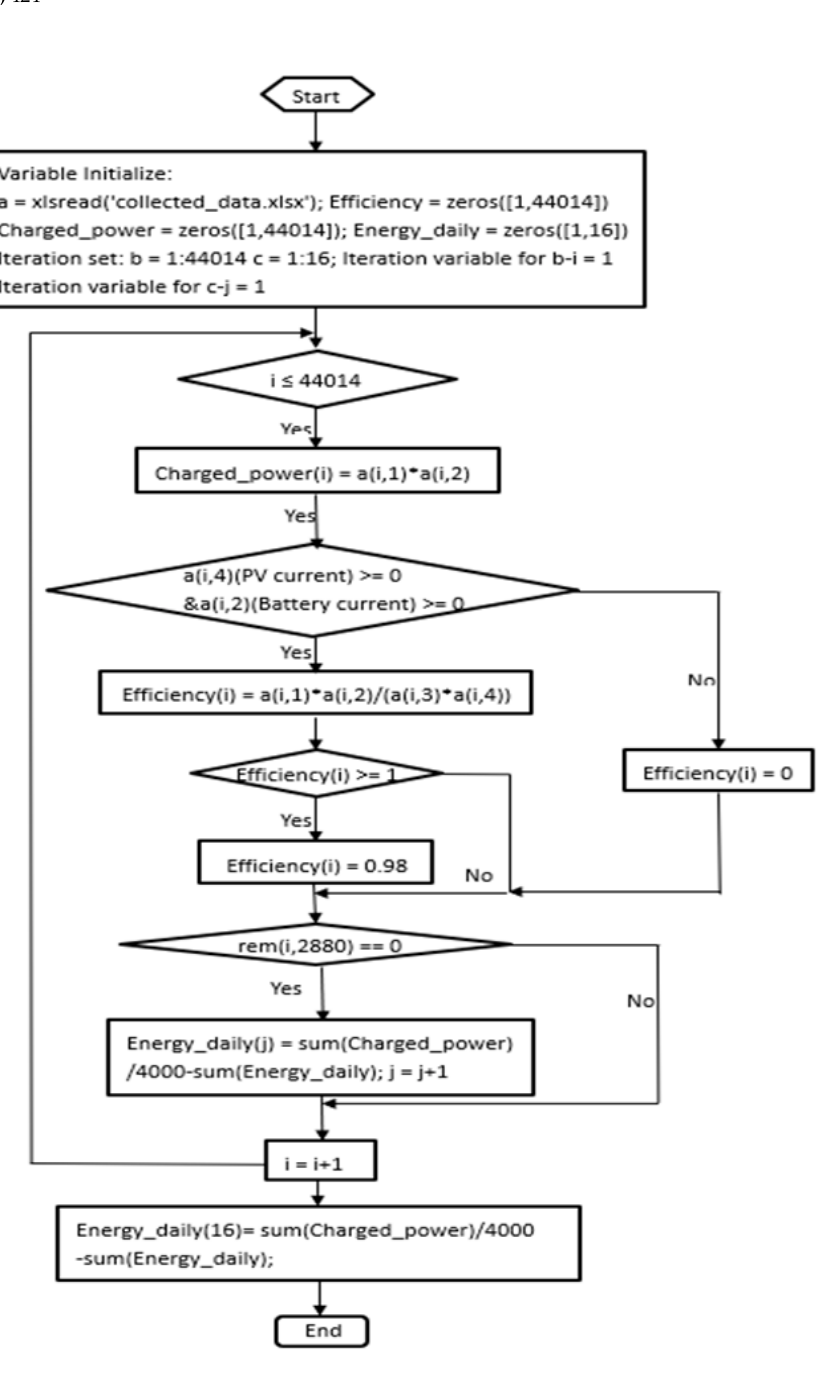
Figure 22. Flow chart of data analysis in MATLAB.